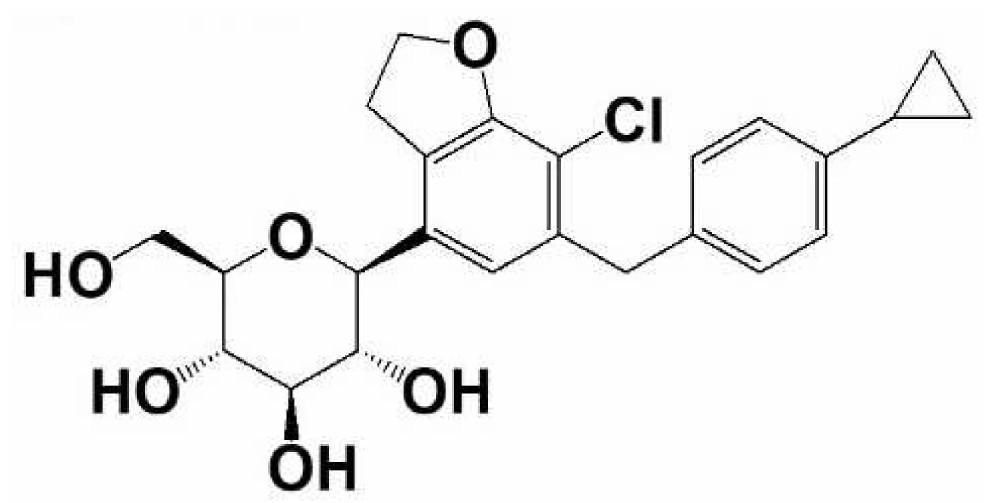
Figure 1. Structure of